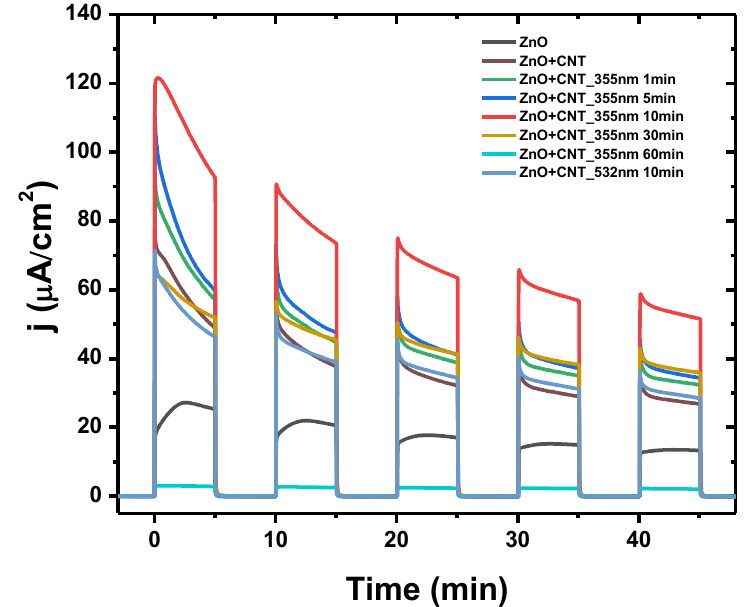
Figure 8. Photoelectrochemical measurements showing the transient response of ZnO NS and ZnO NS-CNT hybrids under UV–vis irradiation in a 0.5 M Na 2 SO 4